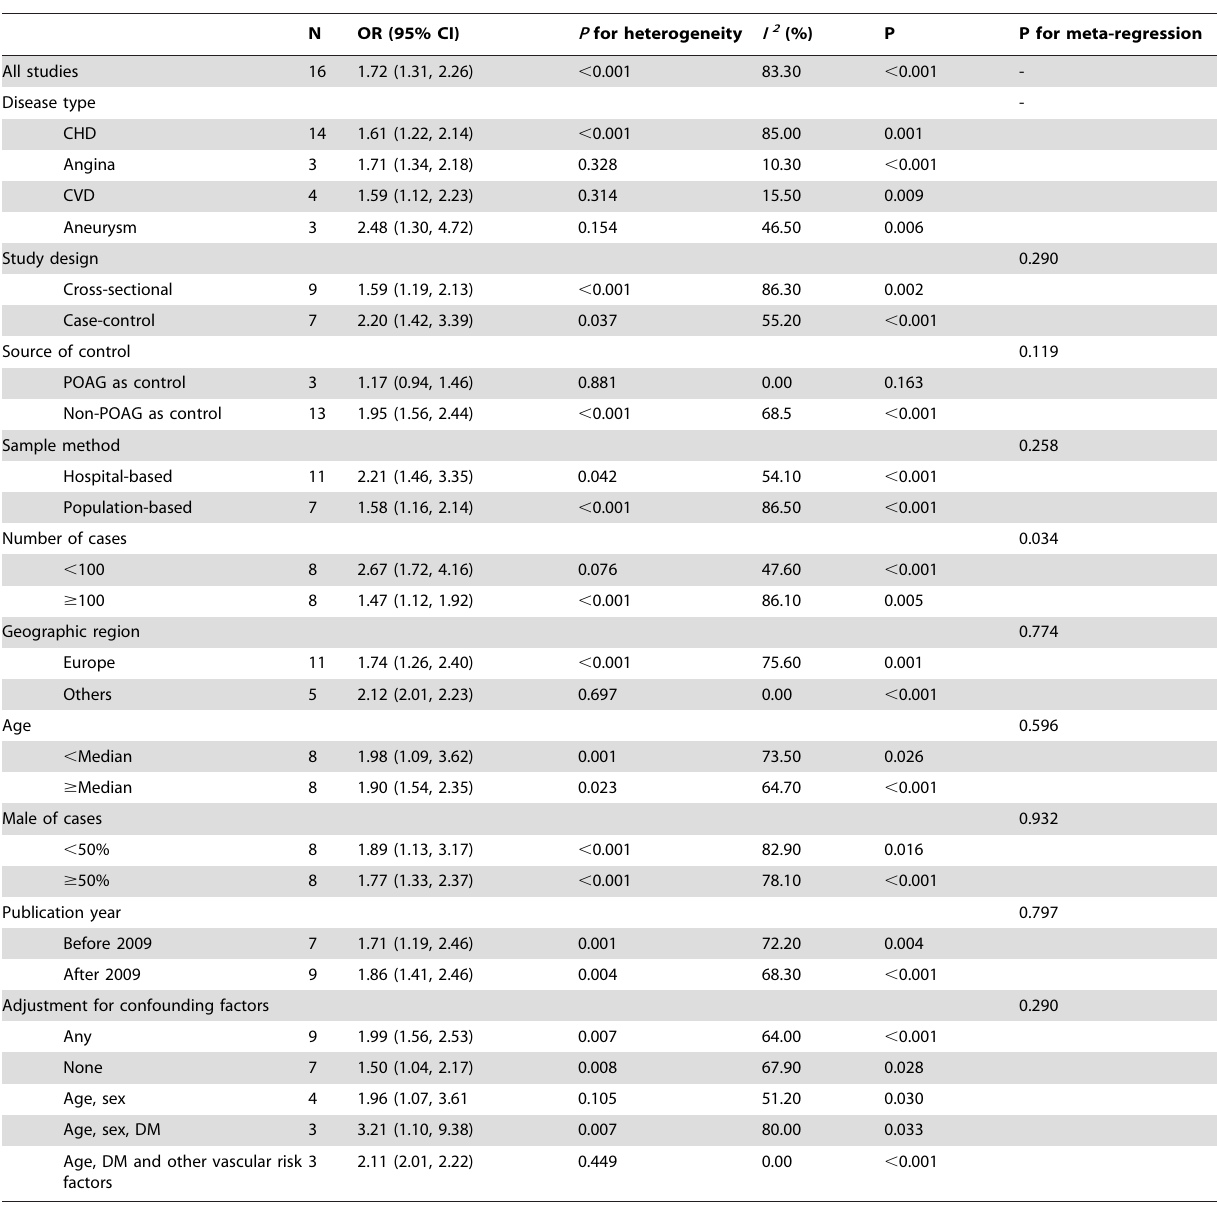
Table 2. Combined OR of vascular disease related to PEX by study design and population characteristics.